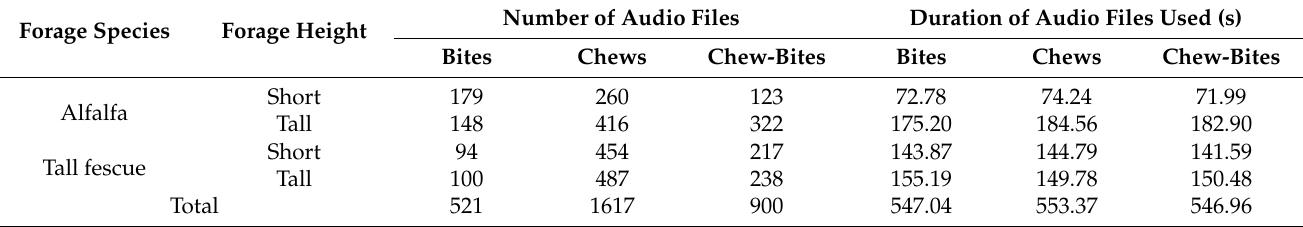
Table 1. Number and duration of audio files used for model evaluation and experiments. Forage Species Forage